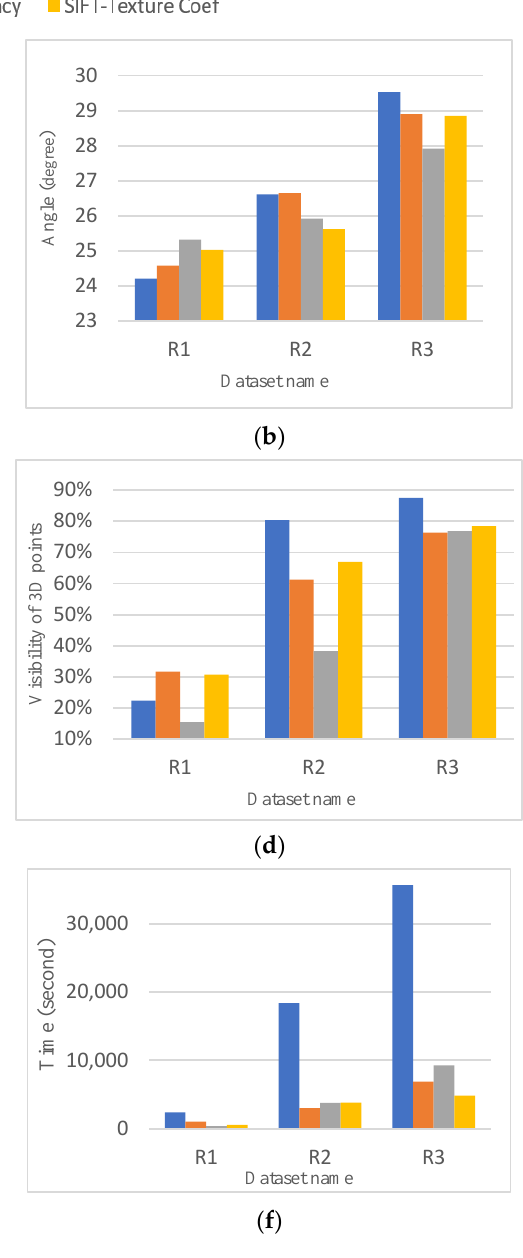
Figure 11. Results for the real image block orientation. ( a ) Re-projection error of the bundle adjustment for each dataset, ( b ) average intersection angles, ( c ) average rays per computed 3D points, ( d ) the visibility of the derived 3D points in more than 3 images, ( e )the number of 3D-points, ( f )processing time.